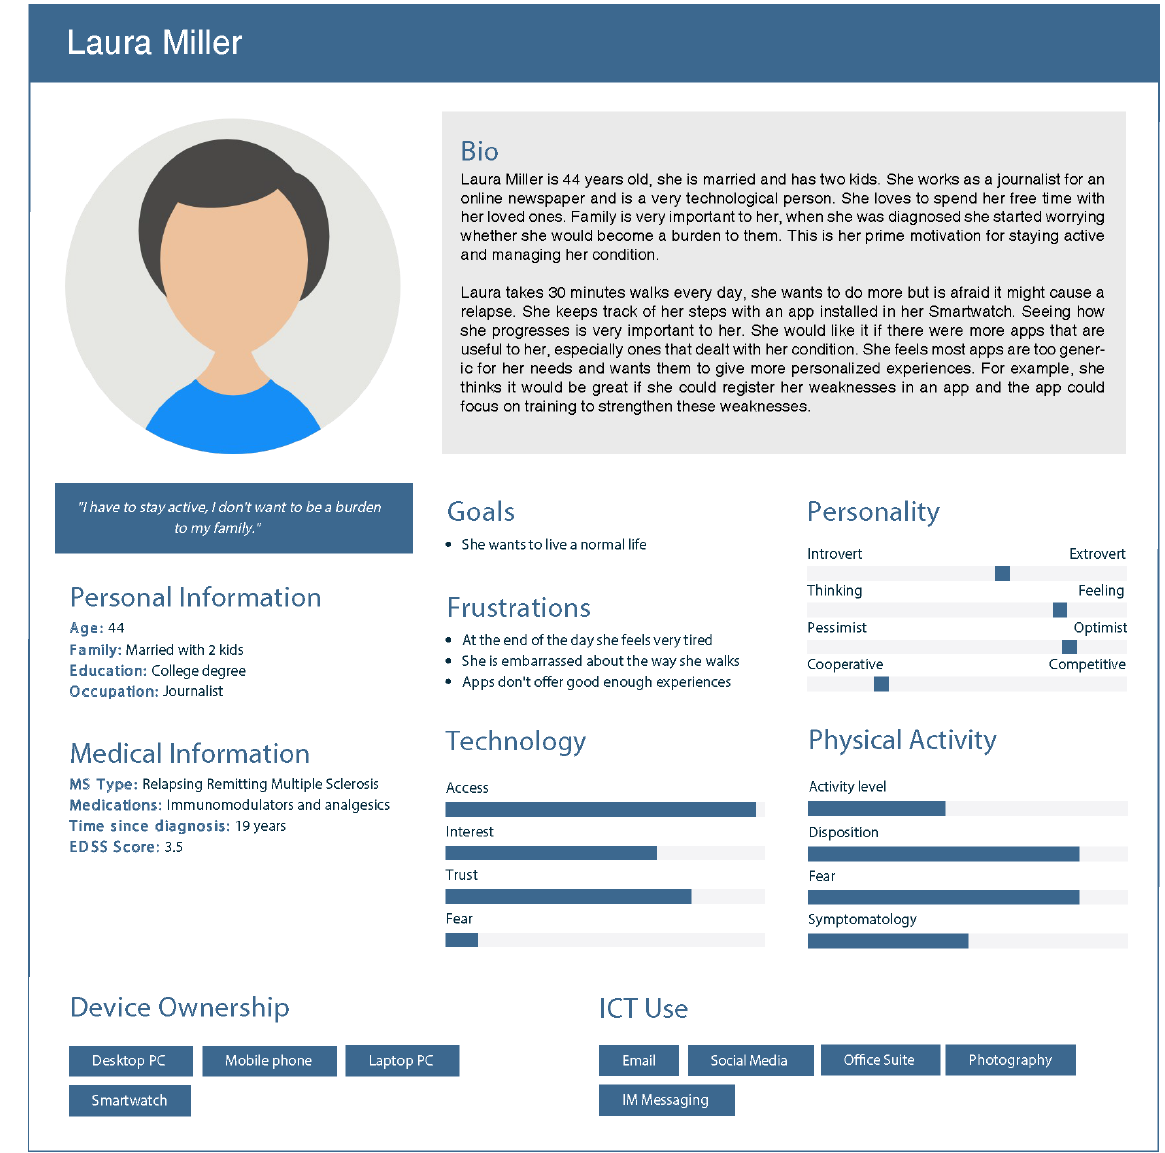
Figure 3. Multiple sclerosis persona with high information and communications technologies and medium physical